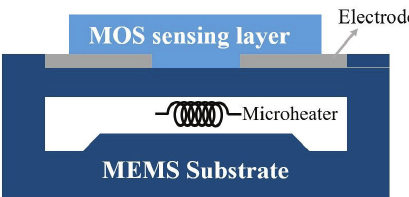
Figure 1. Cross sectional view of a MOS sensor comprising of a set of electrodes, micro-heater, and sensing layer fabricated on a thin suspended membrane using MEMS fabrication technology. The change in the sensing material conductance due to the interaction with analytes is proportional to the concentration of the analytes in the sensor